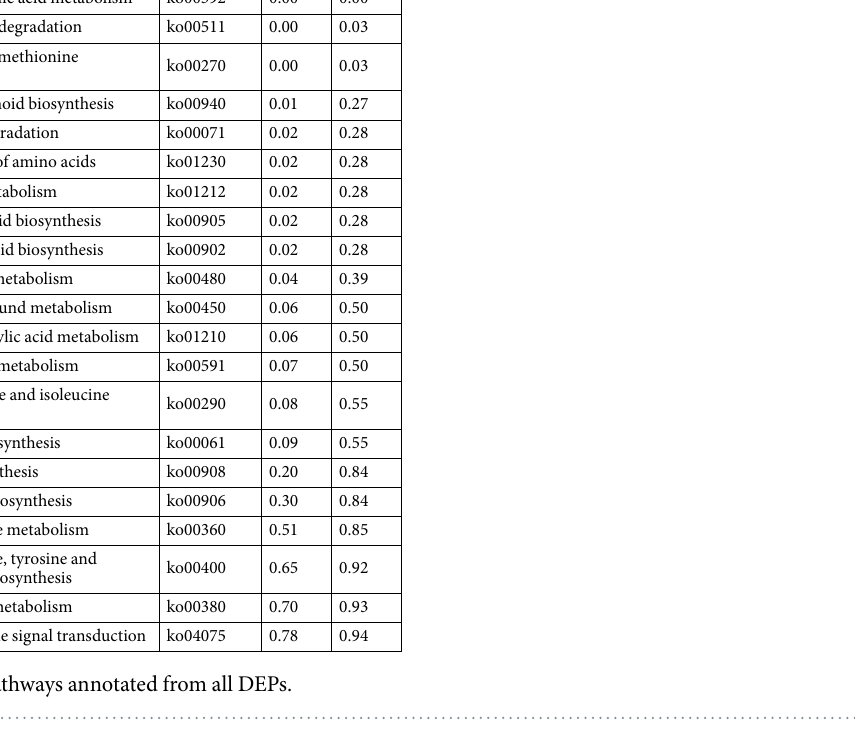
(Fig. 4b). During callus formation, 18R and B73 show different abilities in synthesis, transduction or responding of Jasmonic acid (JA), ethylene (Eth), cytokinin (CK), salicylic acid (SA), auxin, and brassinosteroid (BR). Different Hormone Biosynthesis Patterns in 18R and B73.